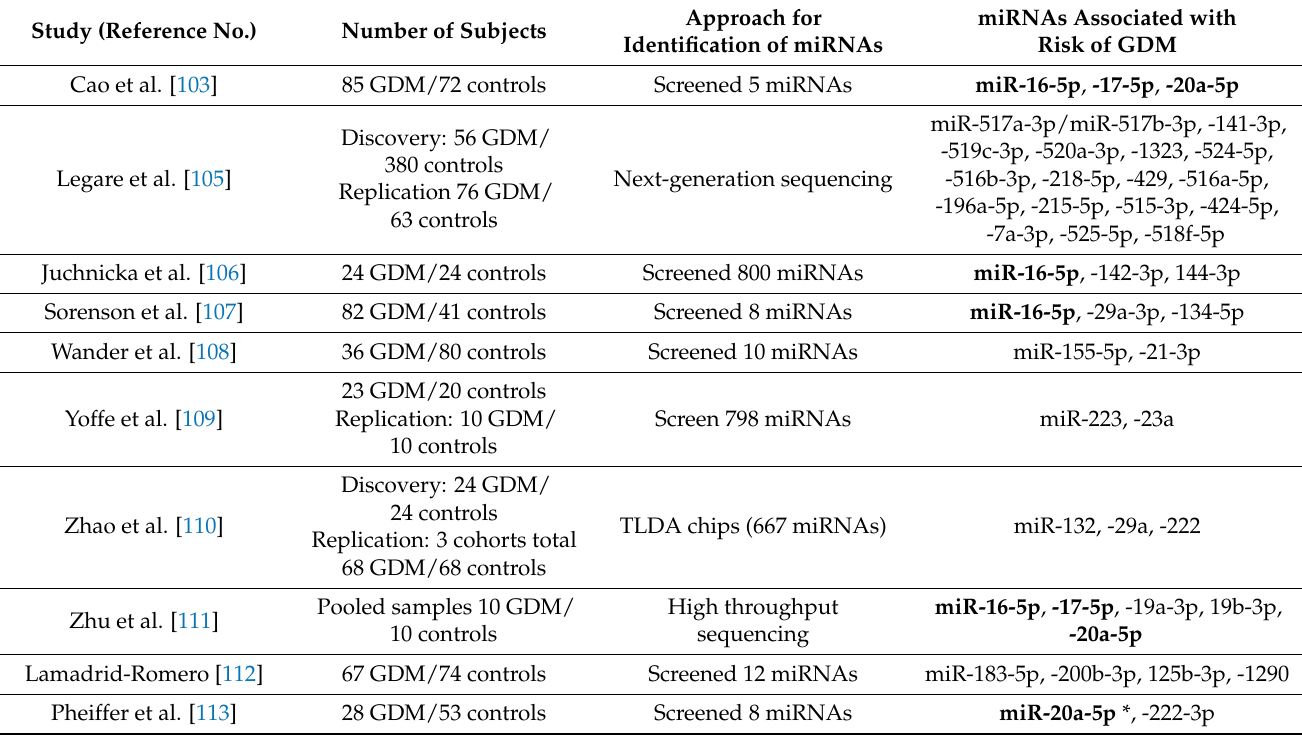
Table 3. MicroRNAs associated with the development of